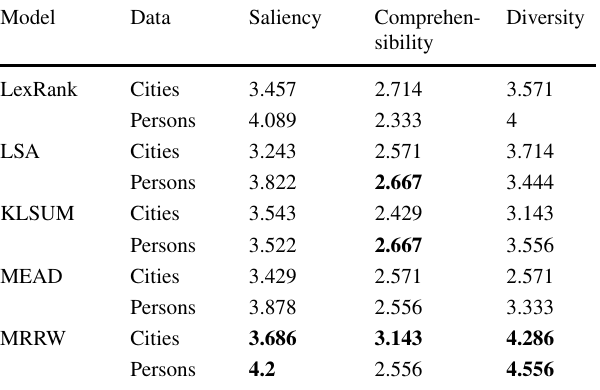
Table 5 Performance of different models on city and person datasets